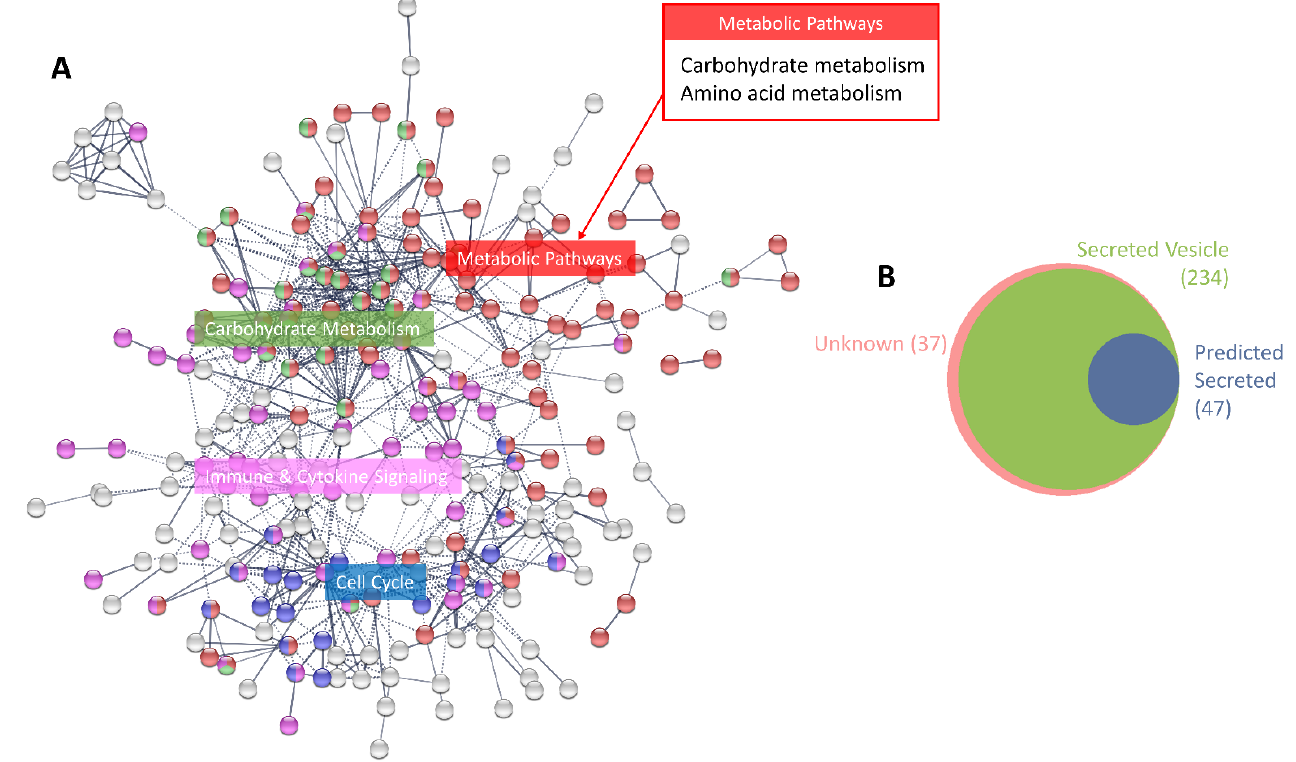
Figure 2. Characterisation of the MCF-7 basal secretome. ( A ) Functional protein association network showing the subset of 231 secreted proteins with known interactions from the total 318 proteins identified in the untreated basal secretome (after cut-offs were applied). Graph produced in STRING based on co-expression with high-confidence interaction score (0.7), clustered using the Markov Clustering algorithm. Significantly enriched pathways from the KEGG [41] and Reactome [42,43] databases are highlighted and labelled (lists of proteins in each pathway are provided in Supplementary Table S3). ( B ) Venn diagram showing proportions of proteins identified in the basal secretome and their reported/predicted method of secretion; (pink) unknown, (green) secreted in exosomes/microvesicles (ExoCarta [47] and Vesiclepedia [48]), and (blue) directly secreted (Human Protein Atlas [49], SignalP [50], Phobius [51] and SPOCTOPUS [52]).